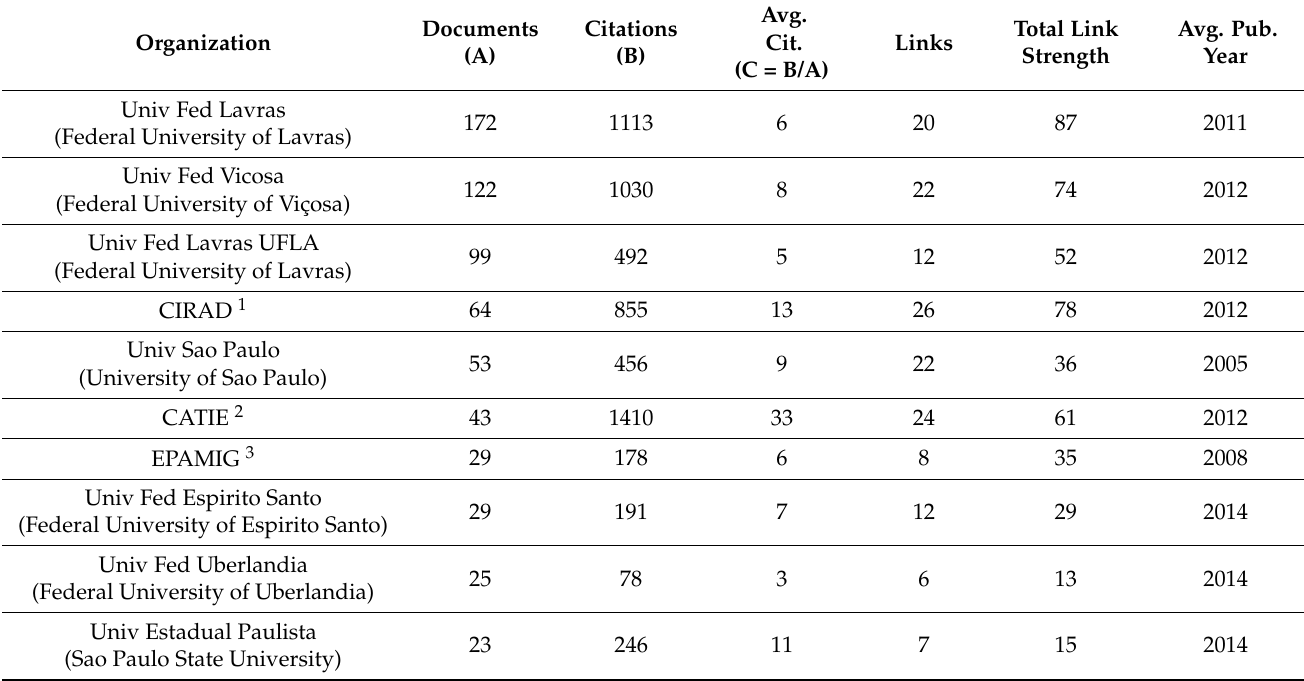
Table 5. Relevant author affiliation organizations in coffee agronomy research.